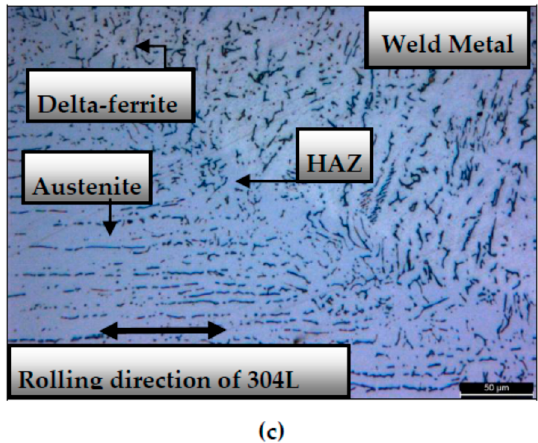
Figure 9. Microstructures of sample welded by ER316L TIG Rod ( a ) weld metal HAZ-420 side; ( b ) weld metal; ( c ) 304L side-HAZ and weld metal (scale: 50 µm). Dominant martensite phase (brownish) with a few amount of delta-ferrite (brighter phase) is observed in right hand side of Figure 9a. Chromium rich carbides are also visible like darker lines and dots. At the left hand side in Figure 9a, as a result of ER316L TIG welding rod, the dominant austenitic phase with a minority of delta-ferrite is observed. In Figure 9b, in weld metal, the dark fields are grain boundary delta ferrite phase and brighter (white) regions indicates the austenite phase. The rolling direction of 304L plate is visible in Figure 9c but as getting closer to weld metal the rolling structure of lines transforms into lamellar delta ferritic structure with white contrasted austenite phase.